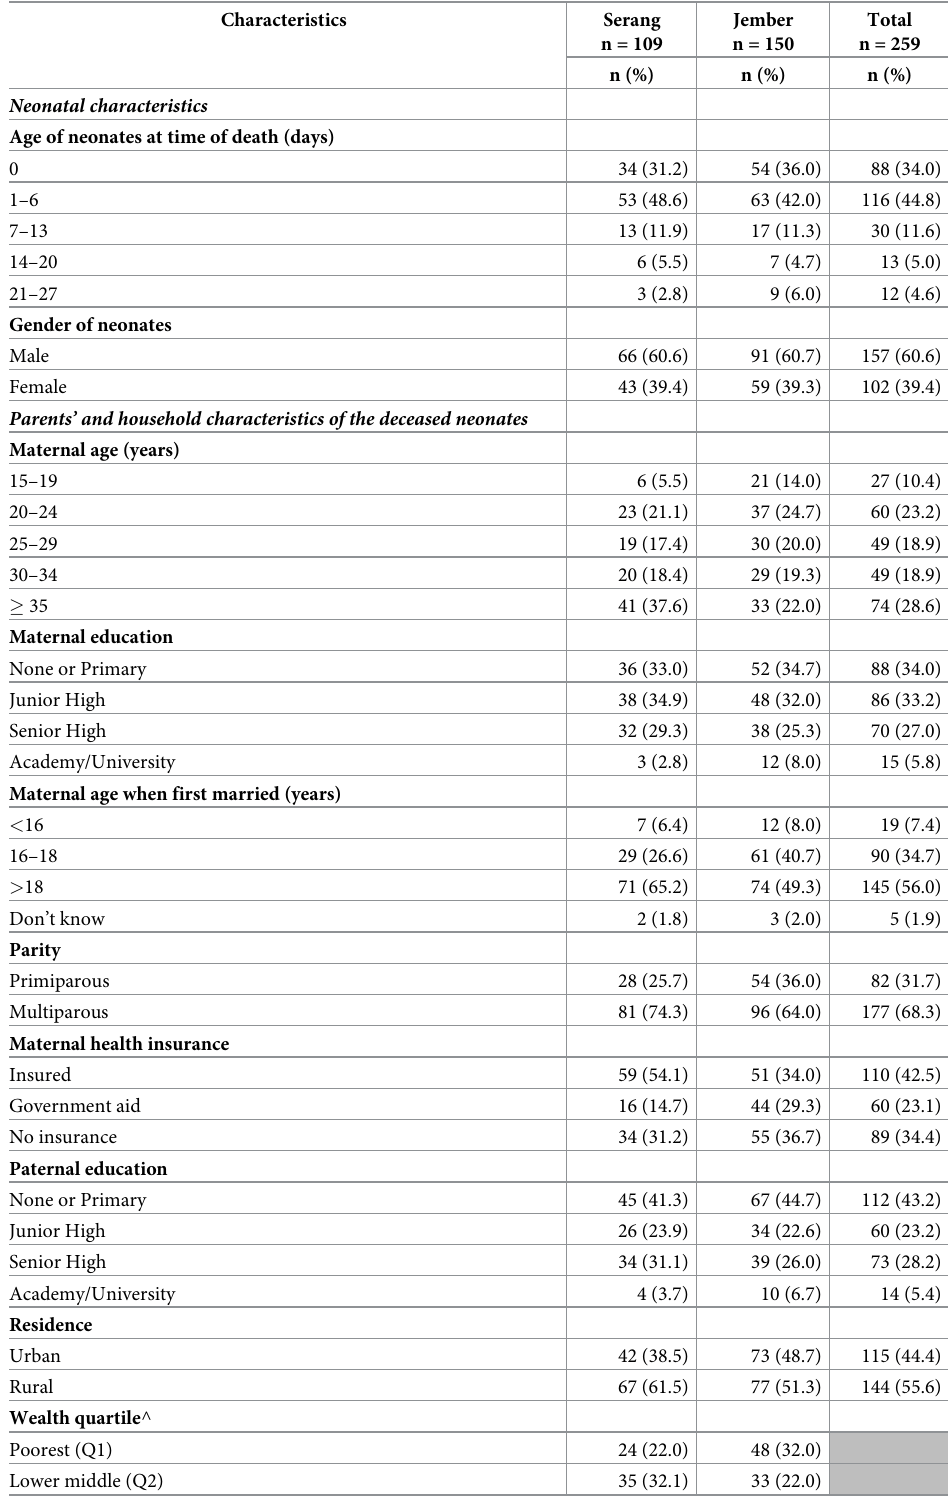
Table 1. Demographic